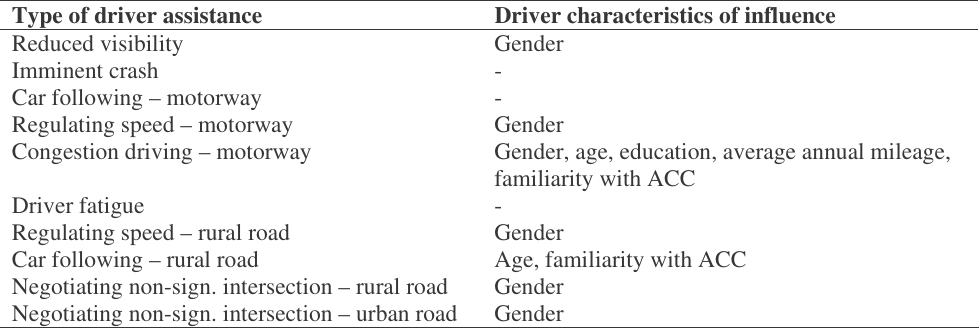
Table 7. Influence of driver characteristics on types of driver assistance in ideal